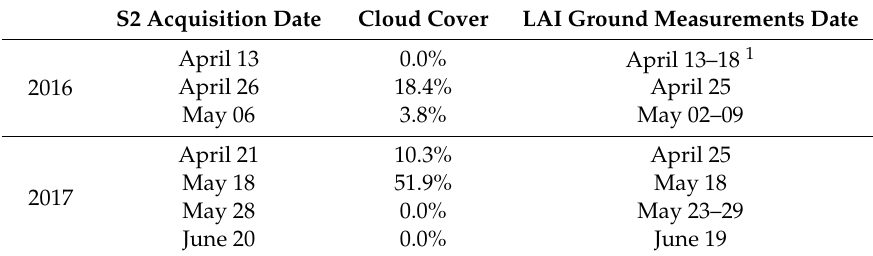
Table 1. List of Sentinel-2 (S2) acquisitions and dates of LAI ground measurements (three in 2016 and four in 2017) used for the LAI validation. The cloud cover indicates the percentage of the land surface covered by clouds in the image data.